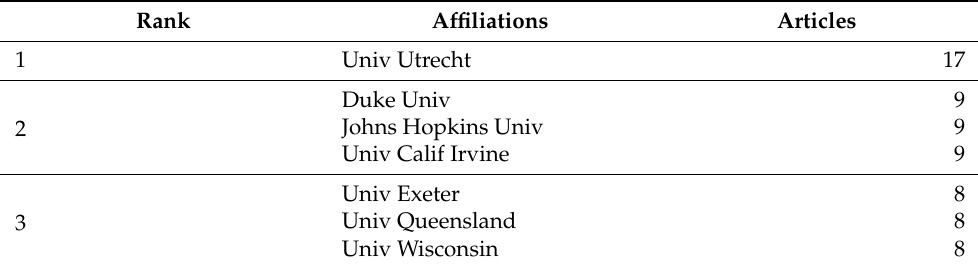
Table 8. Most relevant affiliations. Rank